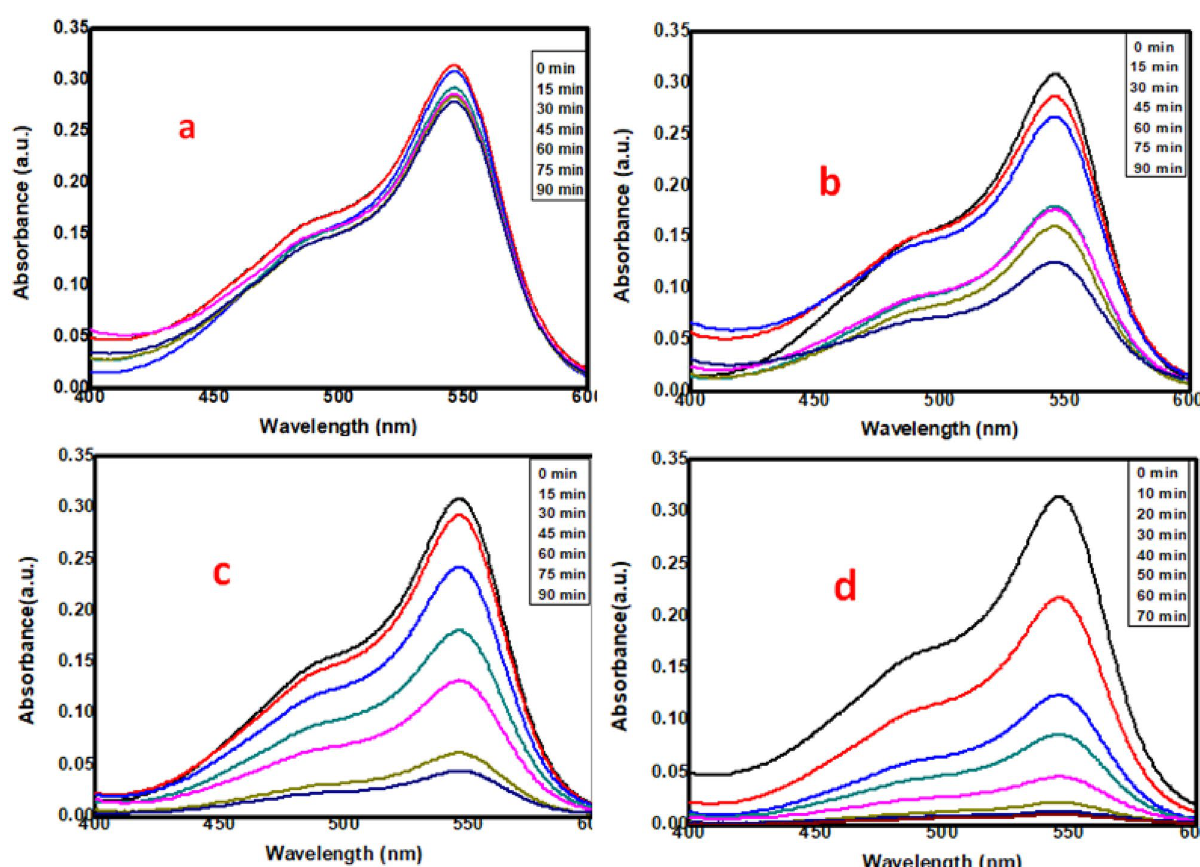
Figure 10. Photocatalytic activity of ( a ) TANI ( b ) Cu 2 O ( c ) TANI/Cu 2 O and ( d ) TANI/Cu 2